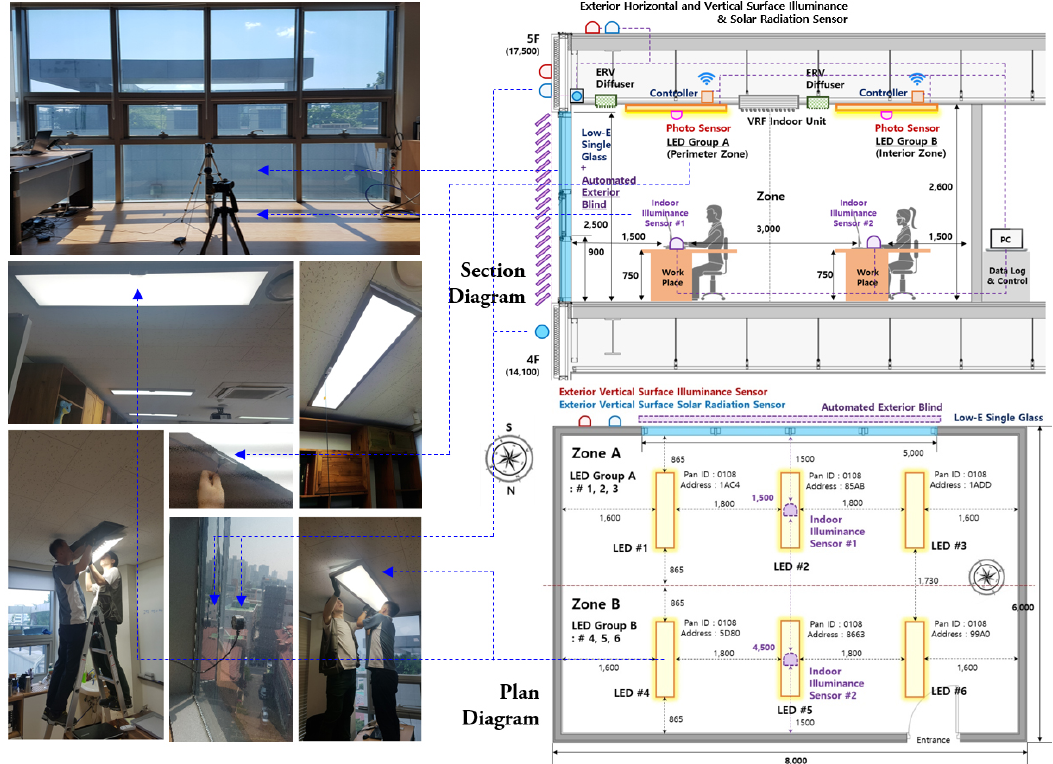
Figure 6. Full-scale mock-up drawings and experimental setup.